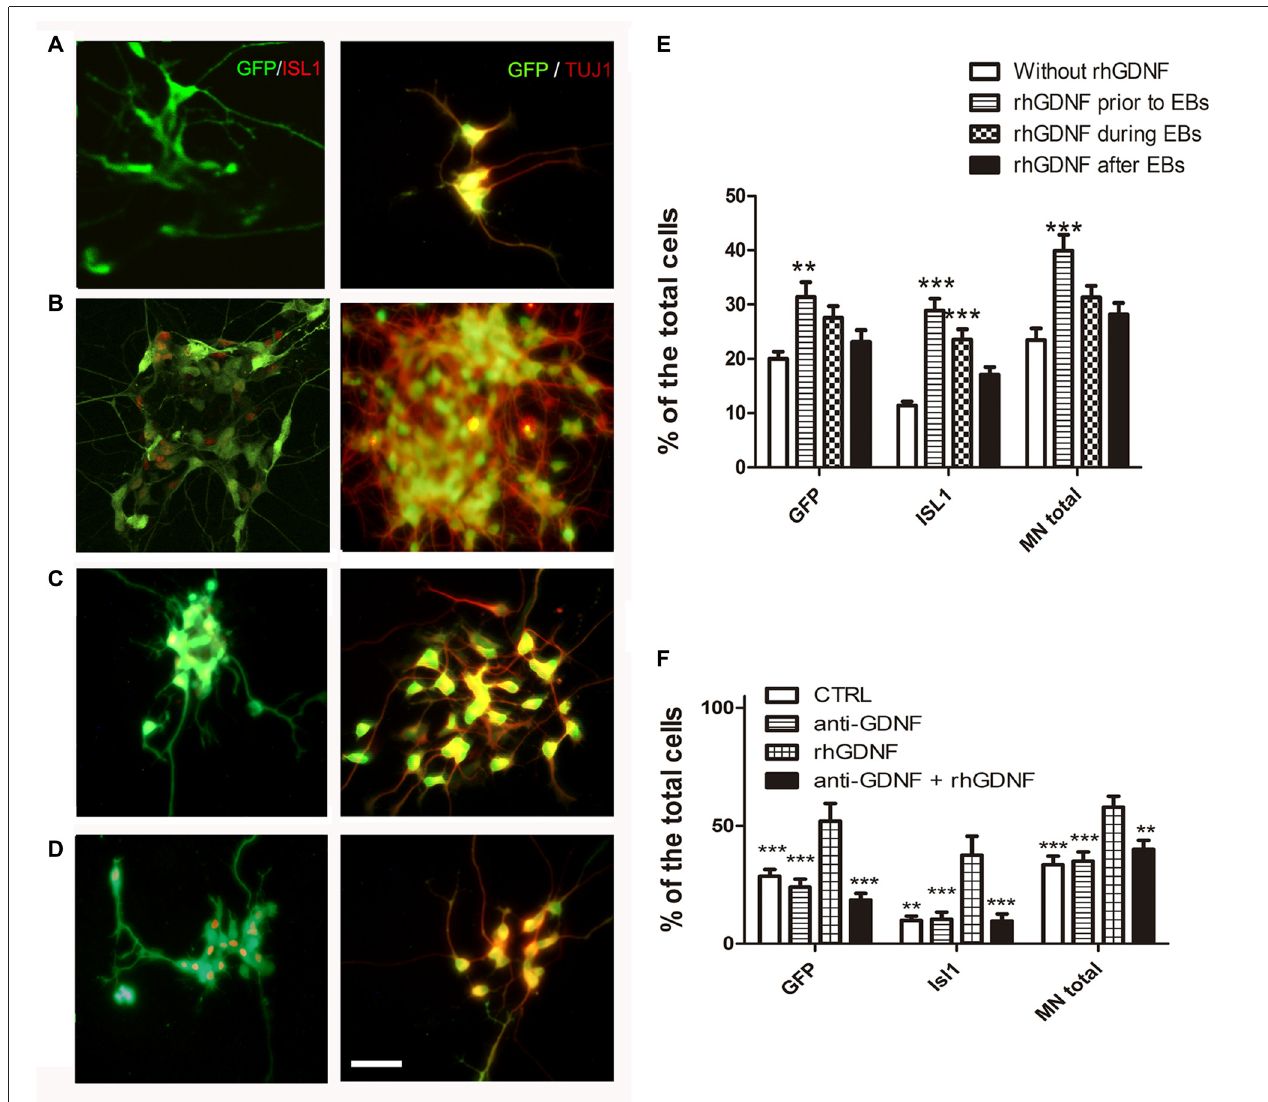
FIGURE 4 | Recombinant hGDNF (rhGDNF) exogenously added at early stages increases differentiation towards MN, which can be prevented by neutralizing anti-GDNF antibodies. CTRL-ESC/HB9::GFP were differentiated without rhGDNF (A) or adding this protein only at specific periods: prior to formation of EBs (B) , during EBs (C) or after EBs (D) . The quantification of total MN differentiation (ISL1 and/or GFP) reveals that early and transient exposure to rhGDNF significantly increases MN induction (E) . ∗∗ p < 0.001 and ∗∗∗ p < 0.0001 compared to differentiation without rhGDNF. Addition of anti-GDNF neutralizing antibodies did not affect differentiation of CTRL-ESC/HB9::GFP (F) . However, co-incubation of rhGDNF and anti-GDNF antibodies, significantly decreased the inductive effect of GDNF. ∗∗ p < 0.001 and ∗∗∗ p < 0.0001 compared to differentiation with rhGDNF. Plot resulting from three independent experiments performed in duplicate. Scale bar: 50 µ